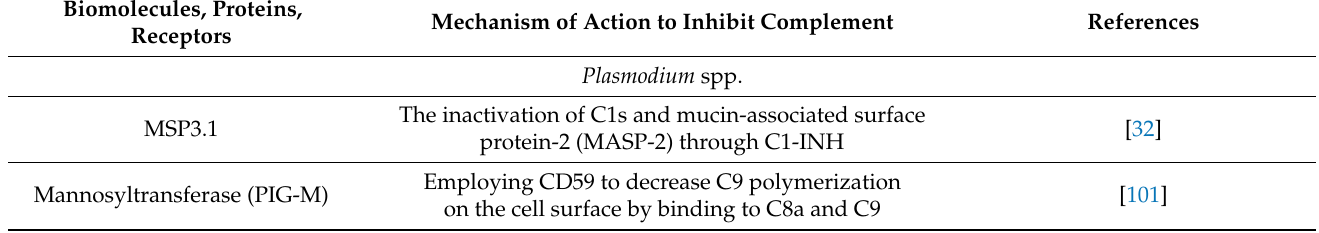
Table 2. Interaction of protozoan parasites with the host’s complement systems through different